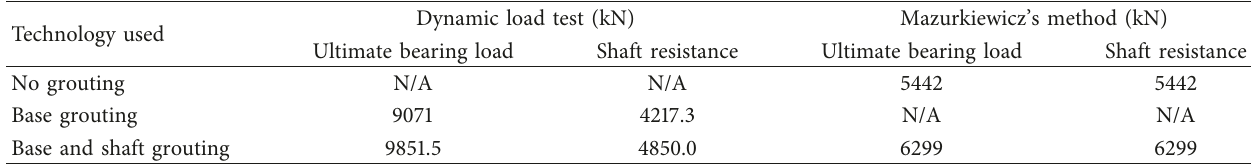
Table 6: Static and dynamic load tests of uplift loaded